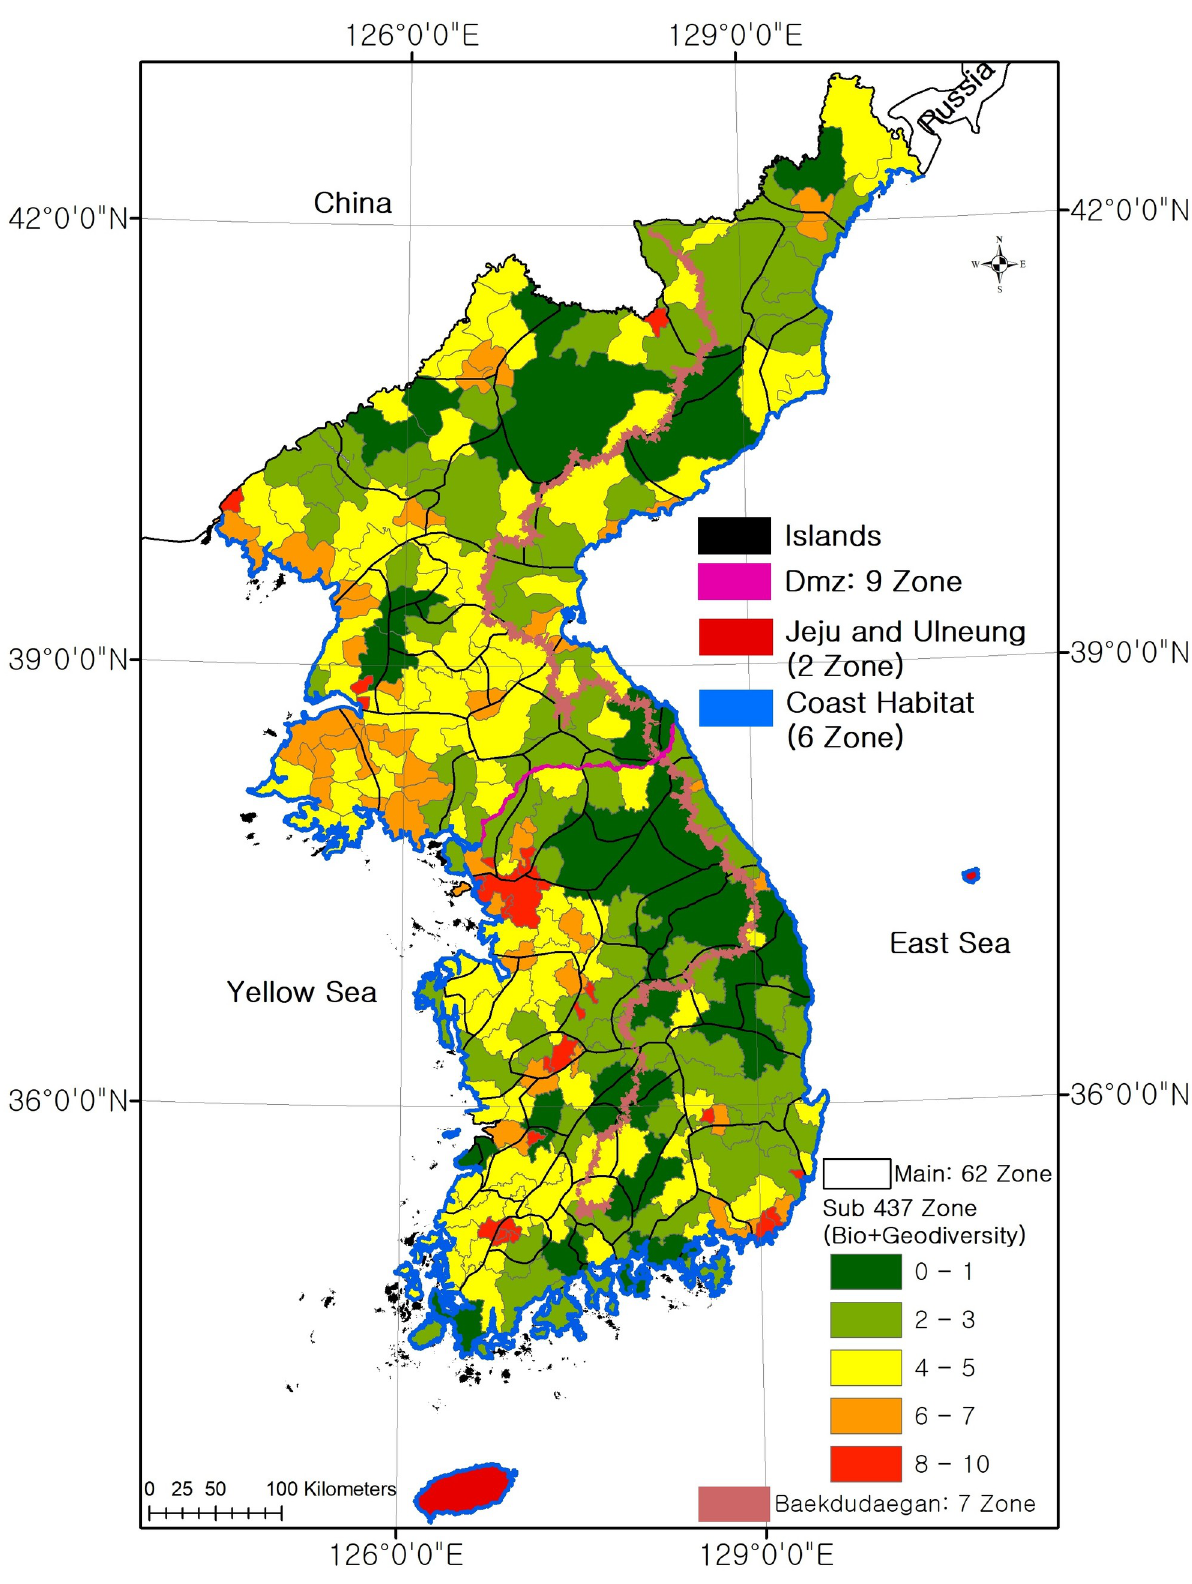
Fig 5. Habitat classification result in Korean Peninsula (base map data source: https://gadm.org/).